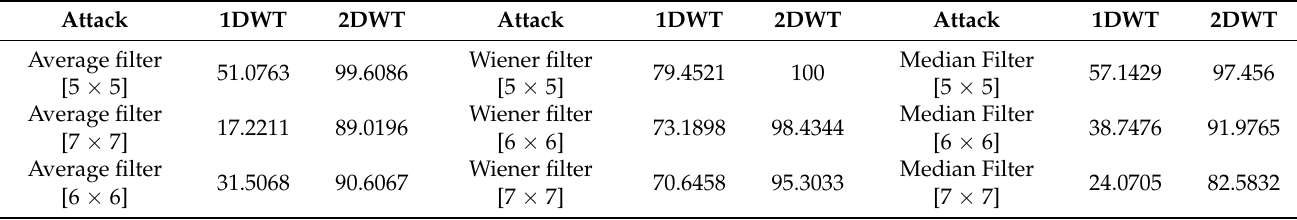
Table 9. BCR (%) values of 1DWT and 2DWT for different filtering